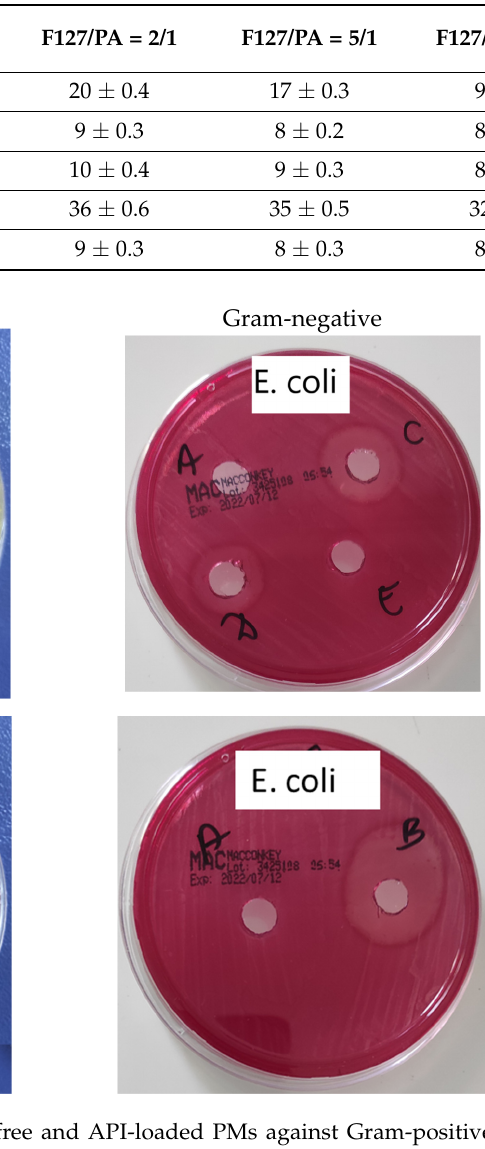
Table 4. Inhibition zone diameter (mm) for different bacterial strains in the presence of free PMs, free API and API-loaded PMs. Concentration was equal to 200 µ g/mL.